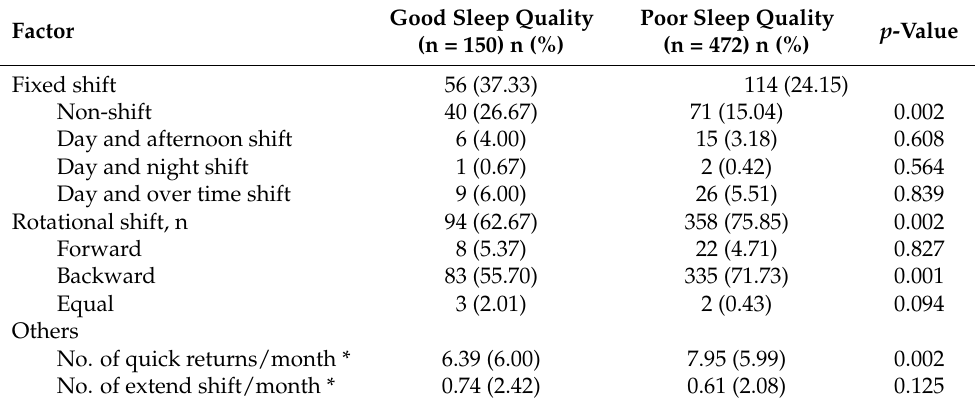
Table 2. Characters of shift patterns of nurses categorized by sleep quality.